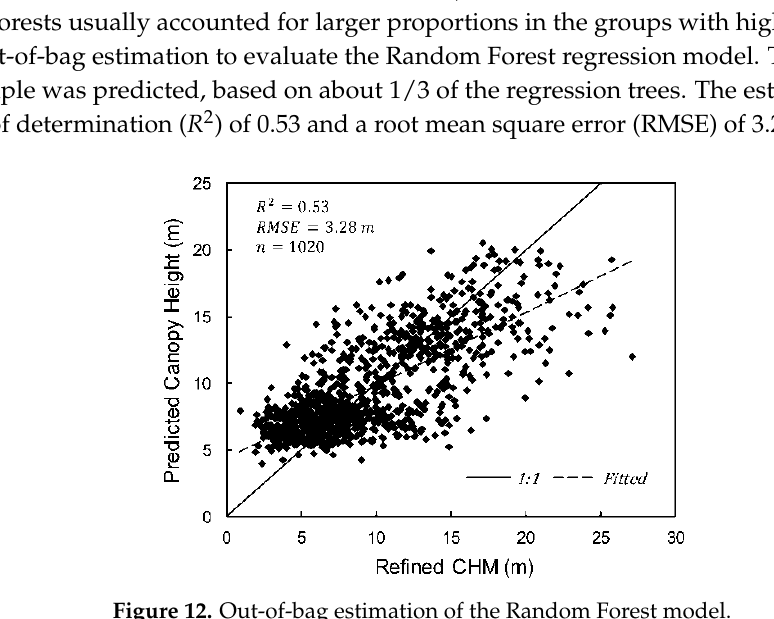
Figure 12. Out-of-bag estimation of the Random Forest